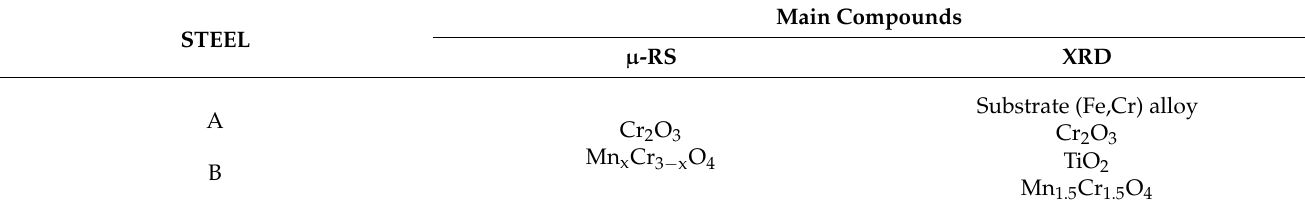
Table 5. Results of Micro-Raman Spectroscopy ( µ –RS) and XRD analyses performed on the surfaces and cross-sections of Steel A and Steel B.